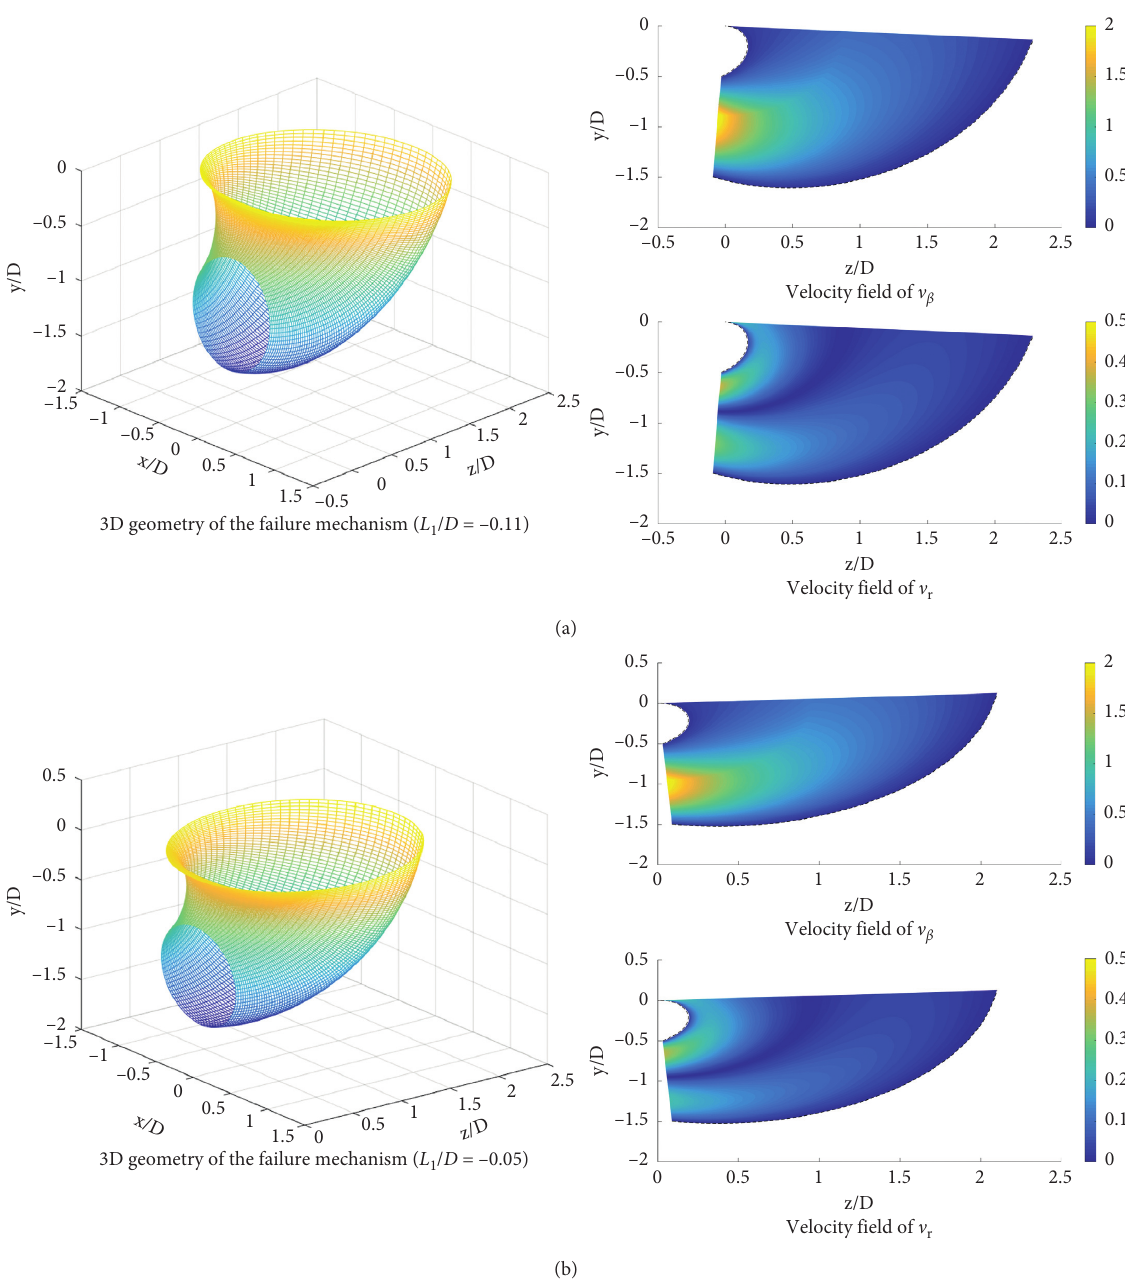
� 10, and η � 6%): (a) tunneling in u